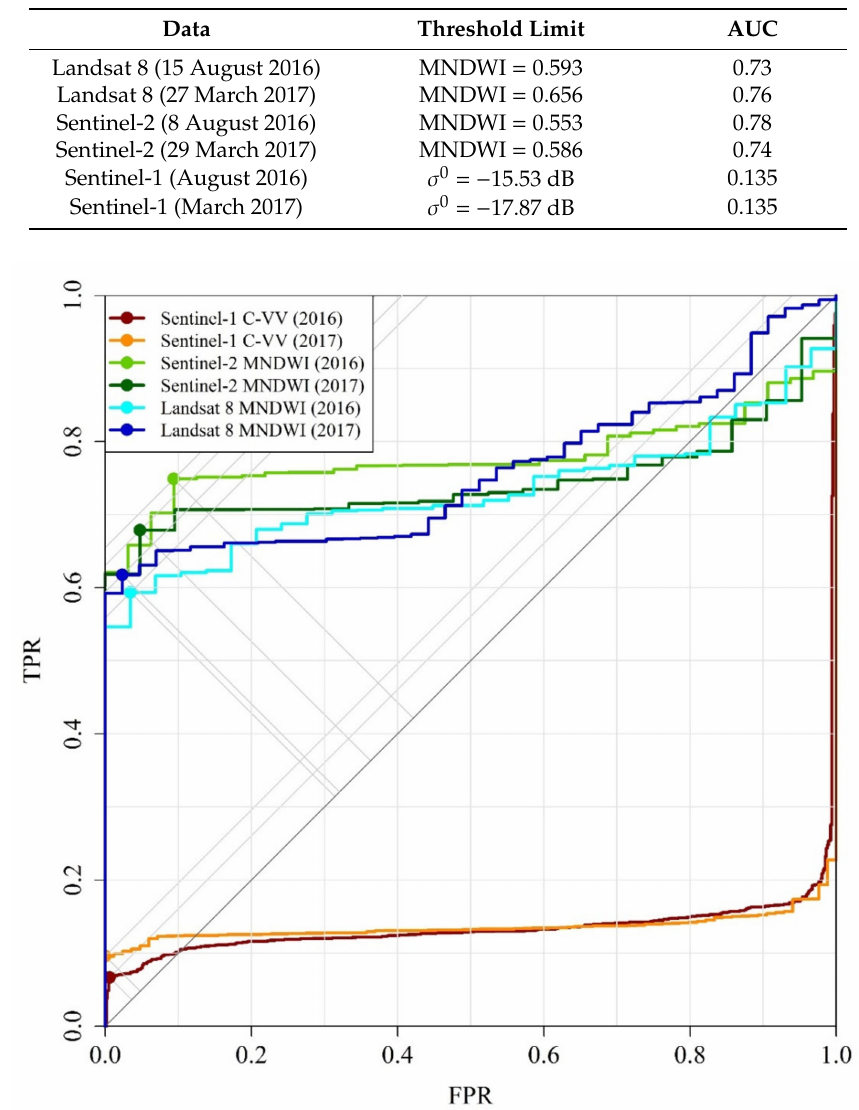
Figure 9. ROC curves calculated for the Sentinel-1 C-VV, Sentinel-2 Modified Normalized Di ff erence Water Index (MNDWI), and Landsat 8 MNDWI data using a Pl é iades image (08 / 09 / 2016) and WorldView-3 (03 / 17 / 2017) high-resolution image obtained via Google Earth Pro; unlike the MNDWI data, no appropriate threshold limit was found for the radar data. TPR denotes true positive rate, and FPR denotes false positive